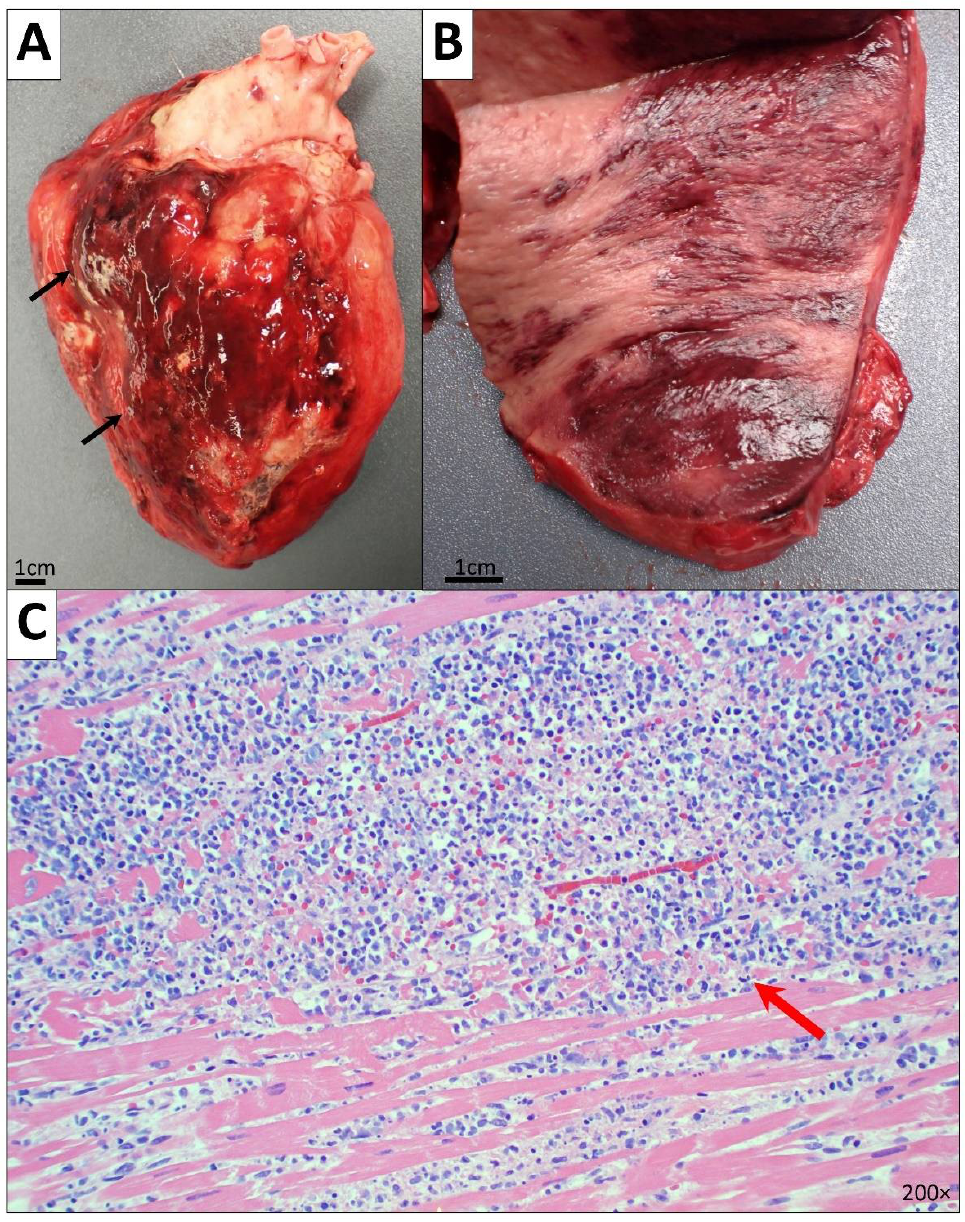
Figure 1. Heart and pericardium. ( A , B ) Gross images of the heart and cut surface of the LV showing cardiomegaly and extensive and diffuse hemorrhagic fibrinous and fibrous adhesions (black arrow), hemorrhage and clotted blood, and fibrinous exudates. ( C ) Microscopic image of the LV myocardium showing myocyte hypertrophy, diffuse interstitial fibrosis, AML cell infiltrates (red arrow), and hemophagocytosis (200× magnification).